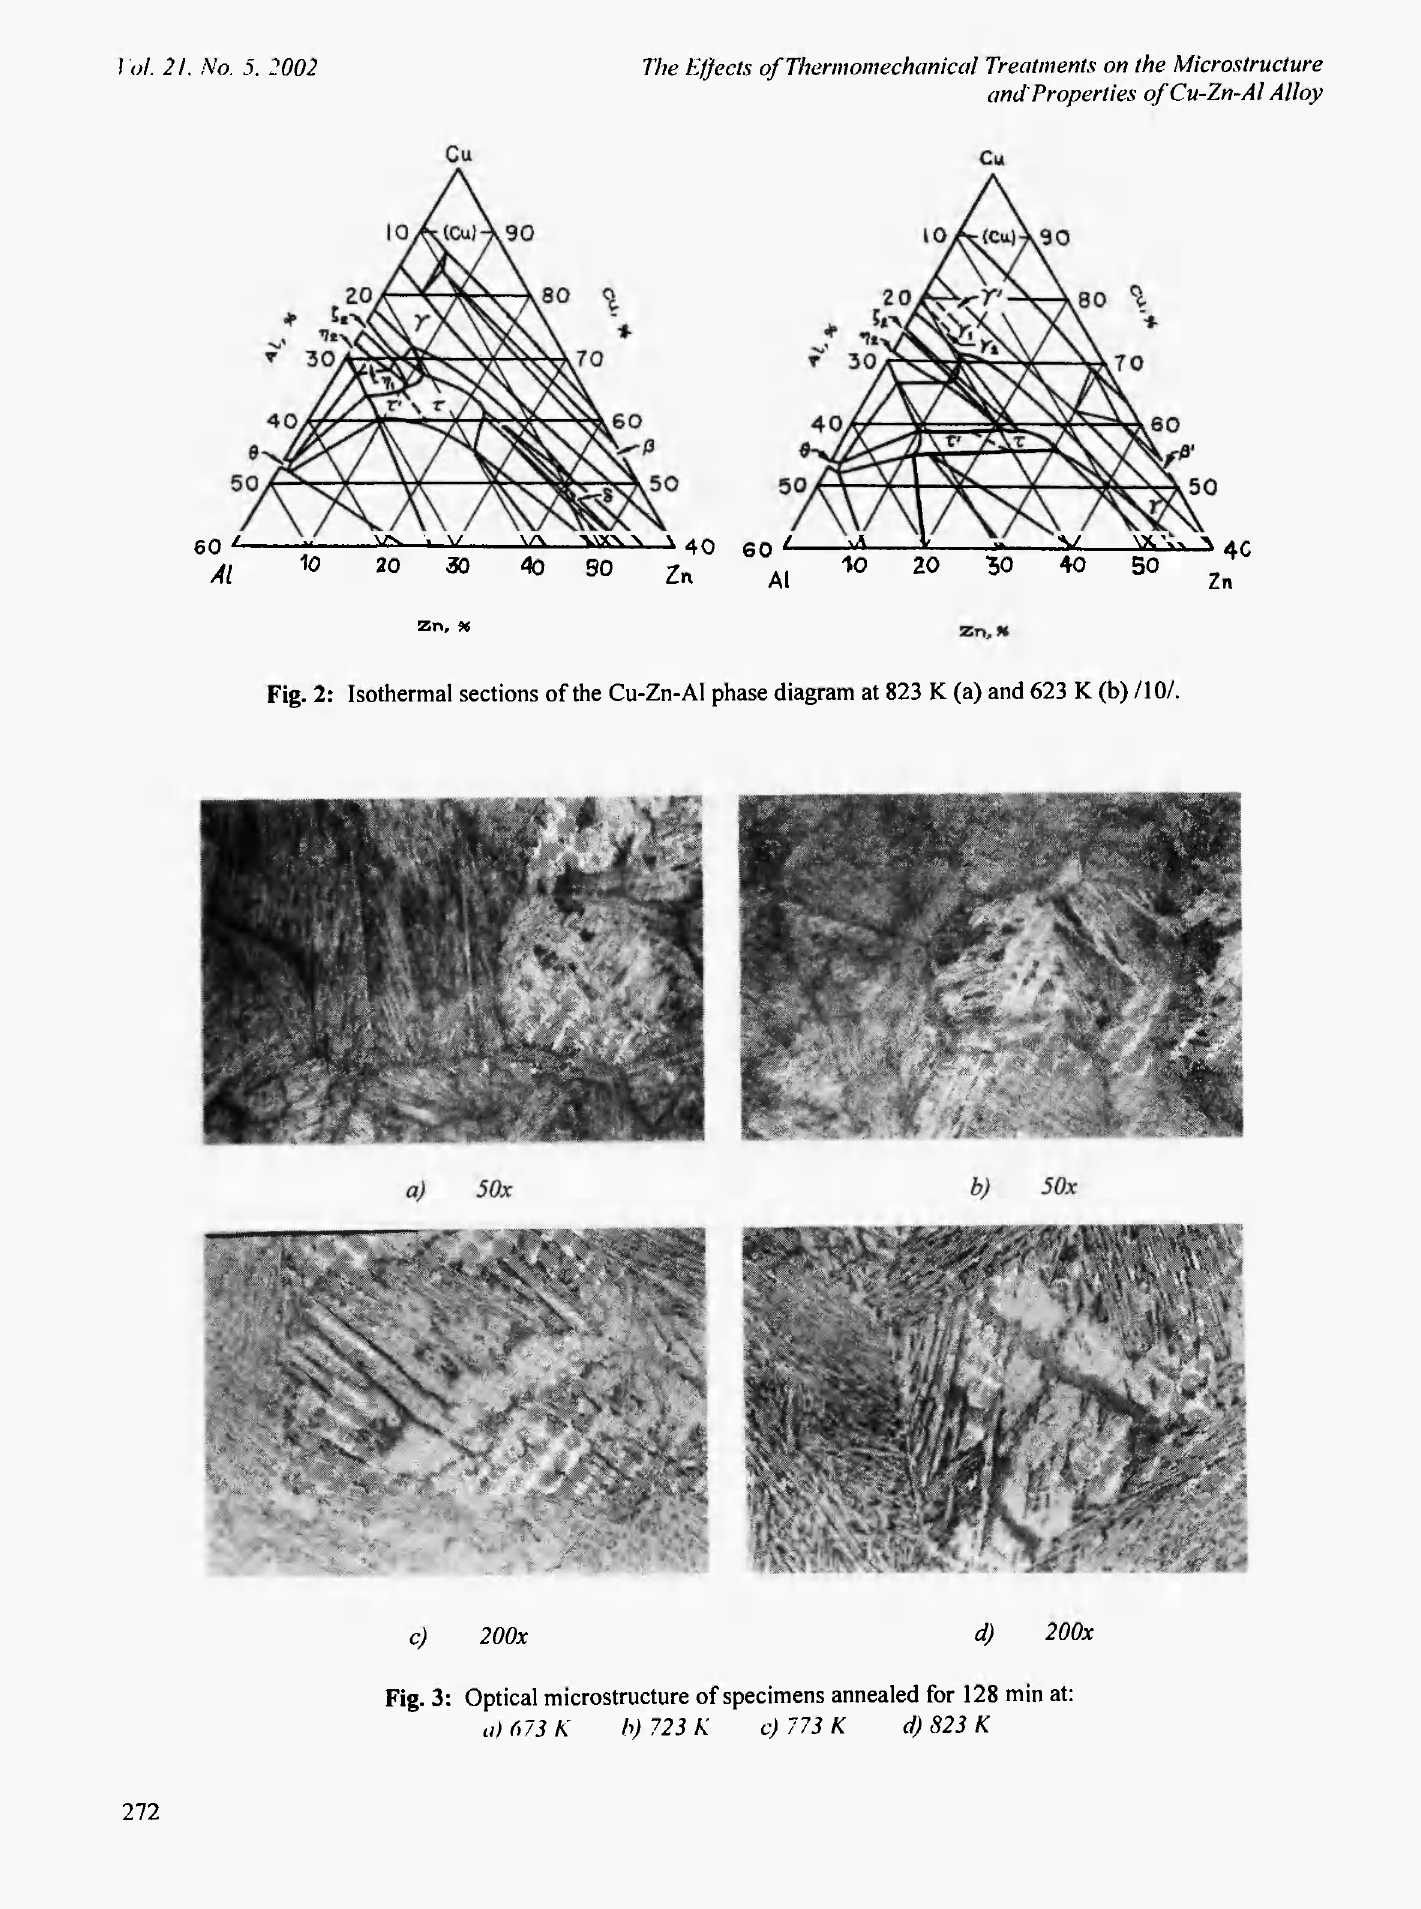
Fig. 2: Isothermal sections of the Cu-Zn-Al phase diagram at 823 Κ (a) and 623 Κ (b) l\OI.